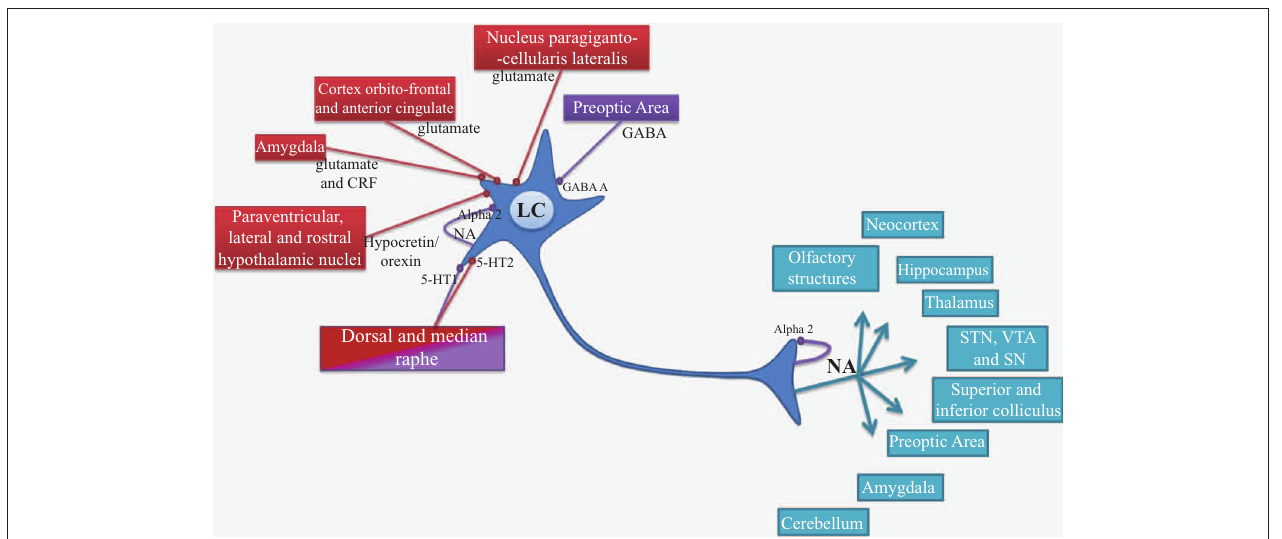
5-HT2, serotonin receptor subtype 1 and 2; CRF, corticotropin releasing factor; STN, subthalamic nucleus; VTA, ventral tegmental area; SN, substantia nigra; NET, noradrenalinergic transporters; Red, excitatory input; Purple, inhibitory input.